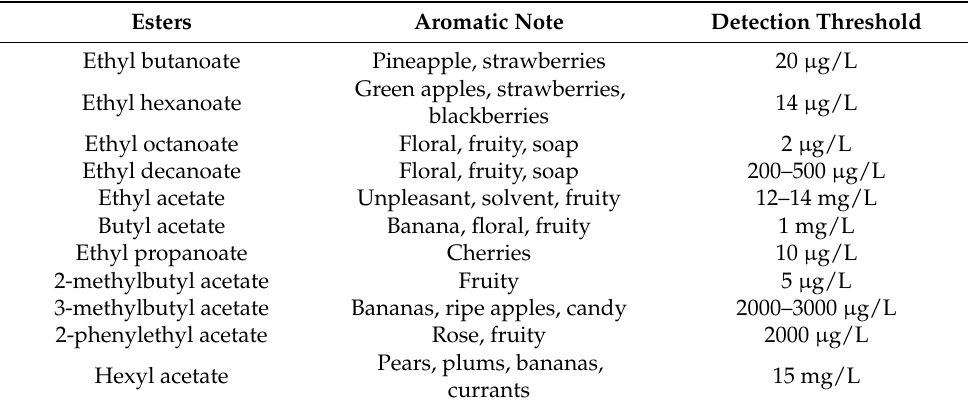
Table 2. Aromatic notes of individual esters [43,44]. Esters Aromatic Note Detection